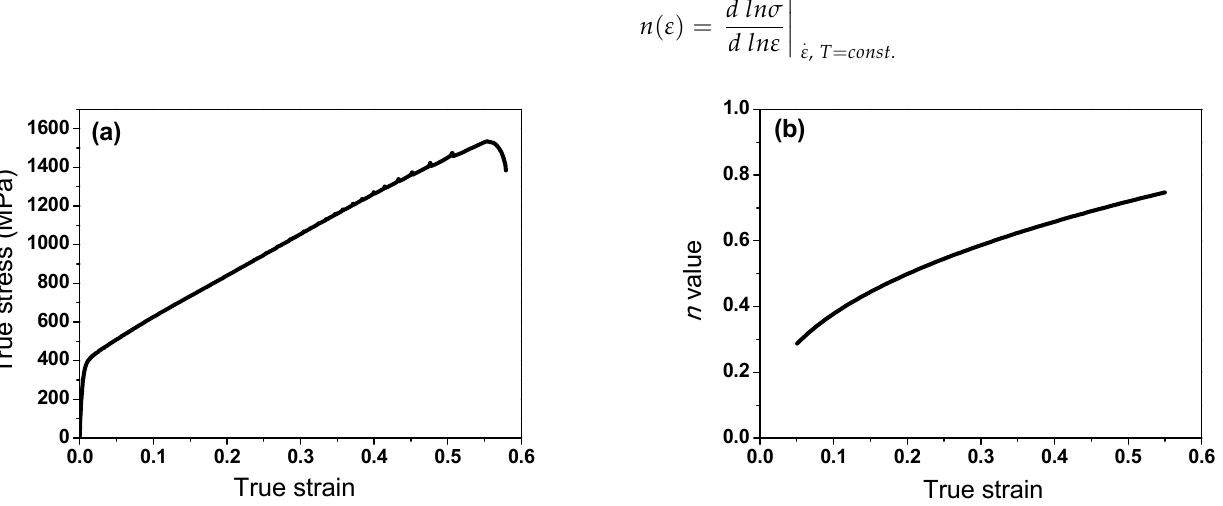
Figure 2. ( a ) True stress–strain curve and ( b ) calculated n of the hot-rolled TWIP steel.